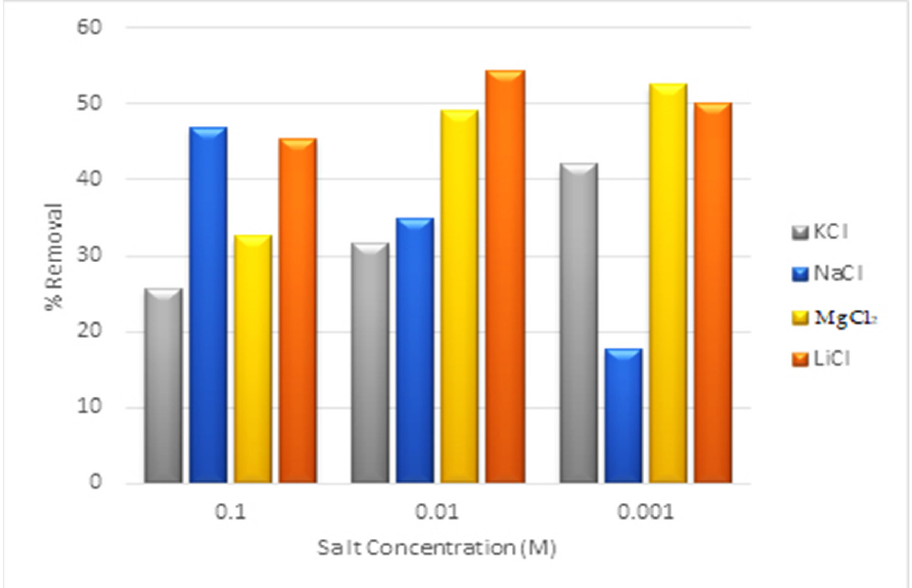
Figure 10. Effect of salts on the efficacy of the adsorption process.